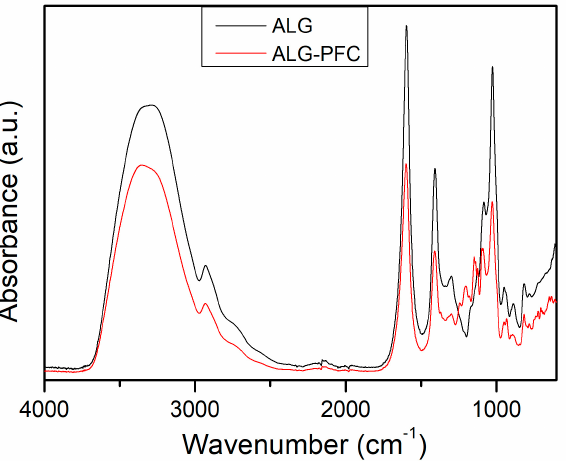
Figure 9. FTIR spectra of sodium alginate (ALG) and sodium alginate with perfluorooctyl (ALG—PFC).